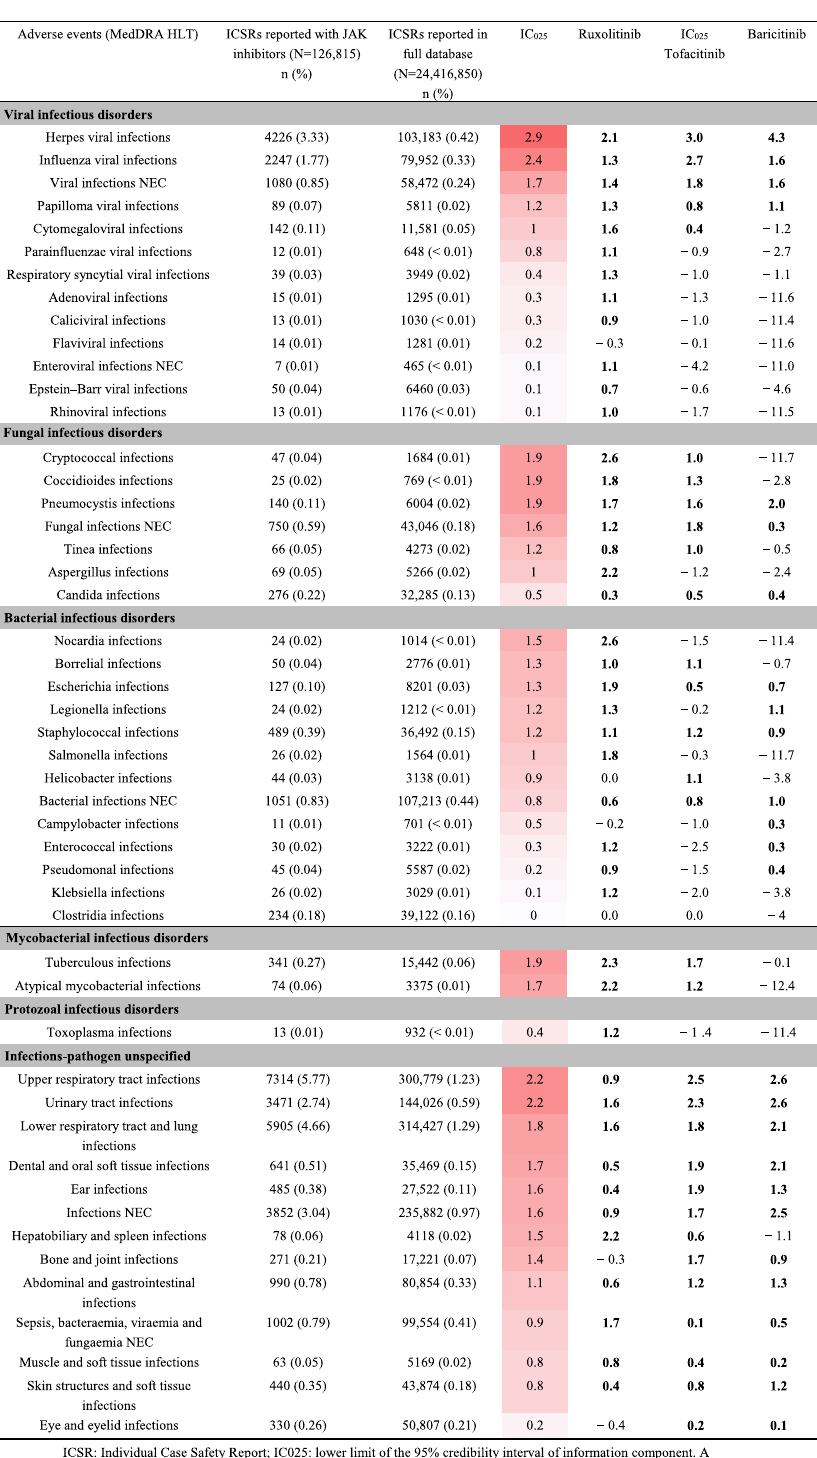
Table 1. Infectious adverse events related to Janus kinase (JAK) inhibitors. Significant values are given in